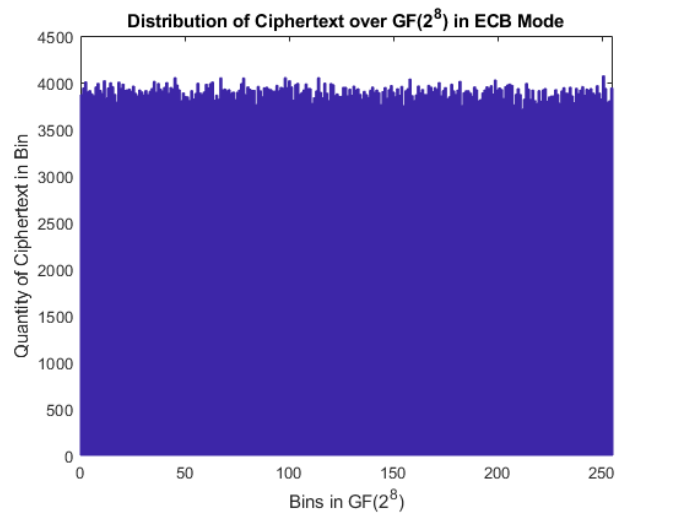
Figure 5. Distribution of ciphertext across GF(2 8 ) (ECB